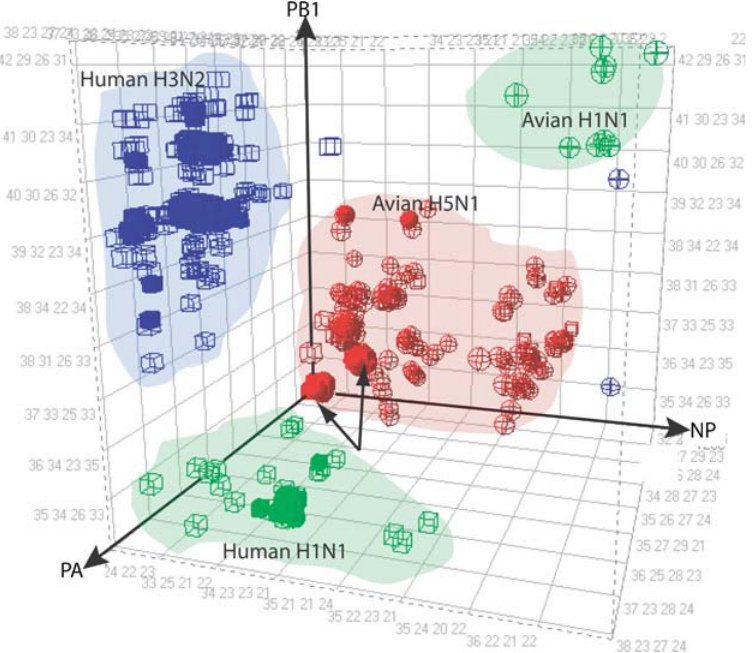
Figure 2. Spatial clustering of influenza virus subtypes. Each axis represents base composition bins (A, G, C, T) from a single primer pair. Solid symbols represent experimental measurements from this study, while open symbols are calculated base compositions determined from published sequences. Human isolates are shown as cubes and avian isolates as spheres. H1N1 isolates are shown in green, H3N2 in blue, and H5N1 in red. Arrows indicate avian influenza viruses isolated from